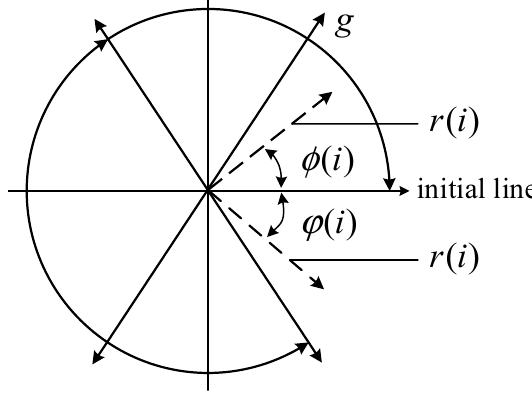
Figure 1. Schematic diagram of the SDP